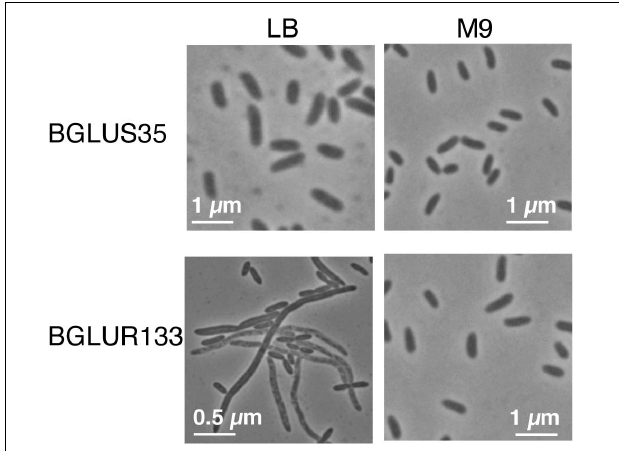
FIGURE 2 | Tn 3 - gusA mutations in gluR resulted in nutrient-dependent cell filamentation. In Lysogeny Broth (LB) medium, the gluR mutant BGLUR133 formed filamentous cells, but a normal rod-shaped cell morphology was observed in M9 minimal medium. No morphological defects were observed in the gluS mutant BGLUS35 in the different culture media.